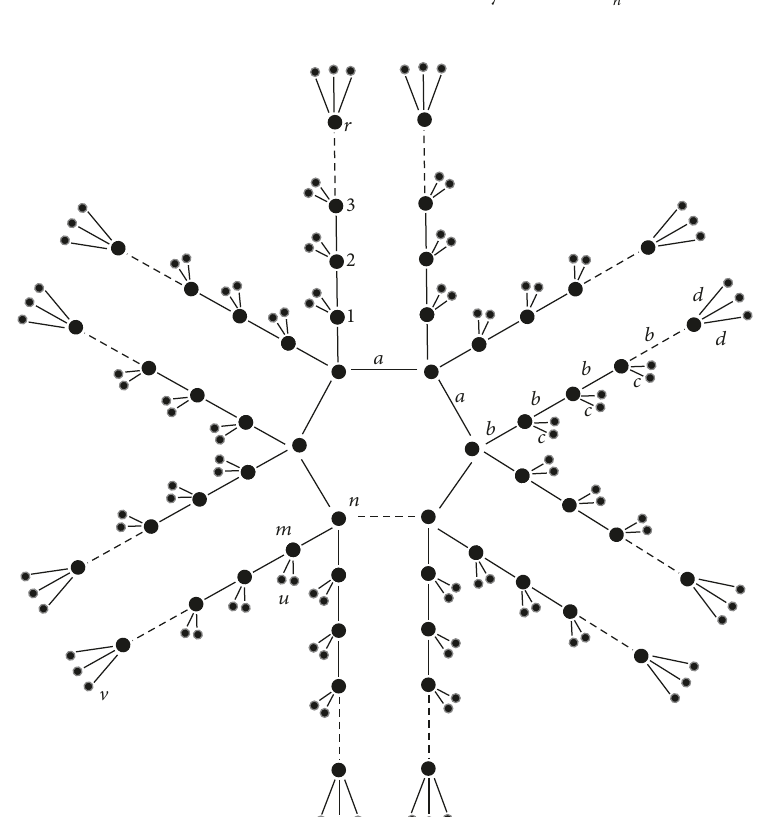
Figure 6: Molecular graph representing the chemical compound of 𝐶 𝑅 𝑖 𝑛